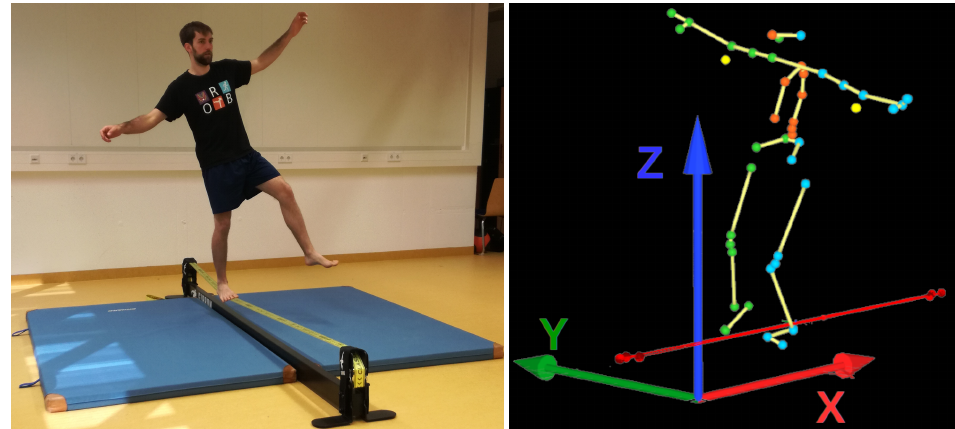
Figure 1. Left: A subject balancing on a slackline. An elastic ribbon band is mounted between two anchor points. The foot contact is able to move sideways and in up and down direction. Right: Kinematic motion capture data of slackline balancing. The coordinate system definition is used throughout this